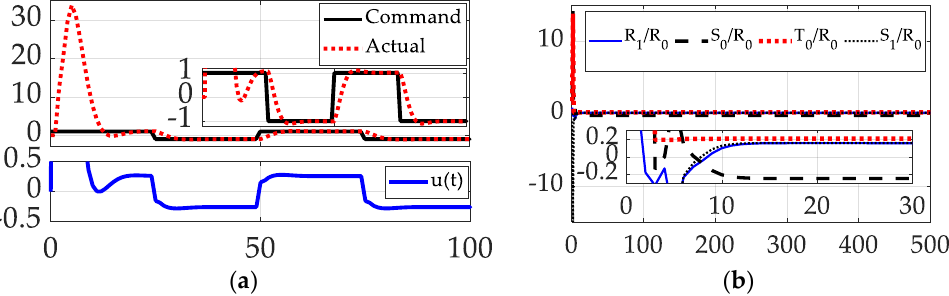
Figure 7. Direct self-tuner with filtering (all process zeros cancelled) where timesteps appear on the abscissa. ( a ) Command and actual output (top); and control (bottom). ( b ) Gain 𝛽 .